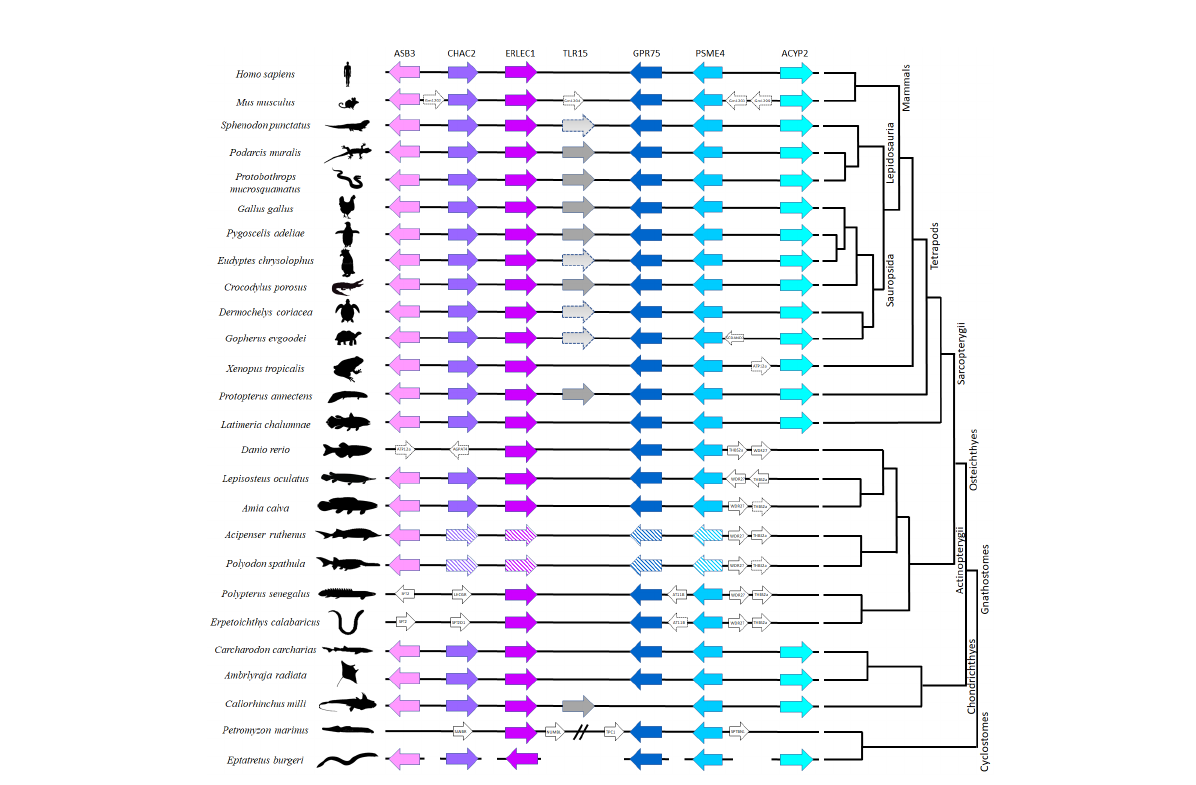
FIGURE 1 Comparative synteny analysis of TLR15 among representative vertebrate species. The same genes are represented in similar color across species. Arrows indicate the direction of translation. The line breaks indicate a larger distance between genes; the line gaps indicate that the genes are in separate chromosomes/Scaffolds and the genes with striped background are duplicated on different chromosomes (Supplementary Table 4). The distances between genes are not scaled, and the corresponding chromosome locations are indicated in Supplementary Table